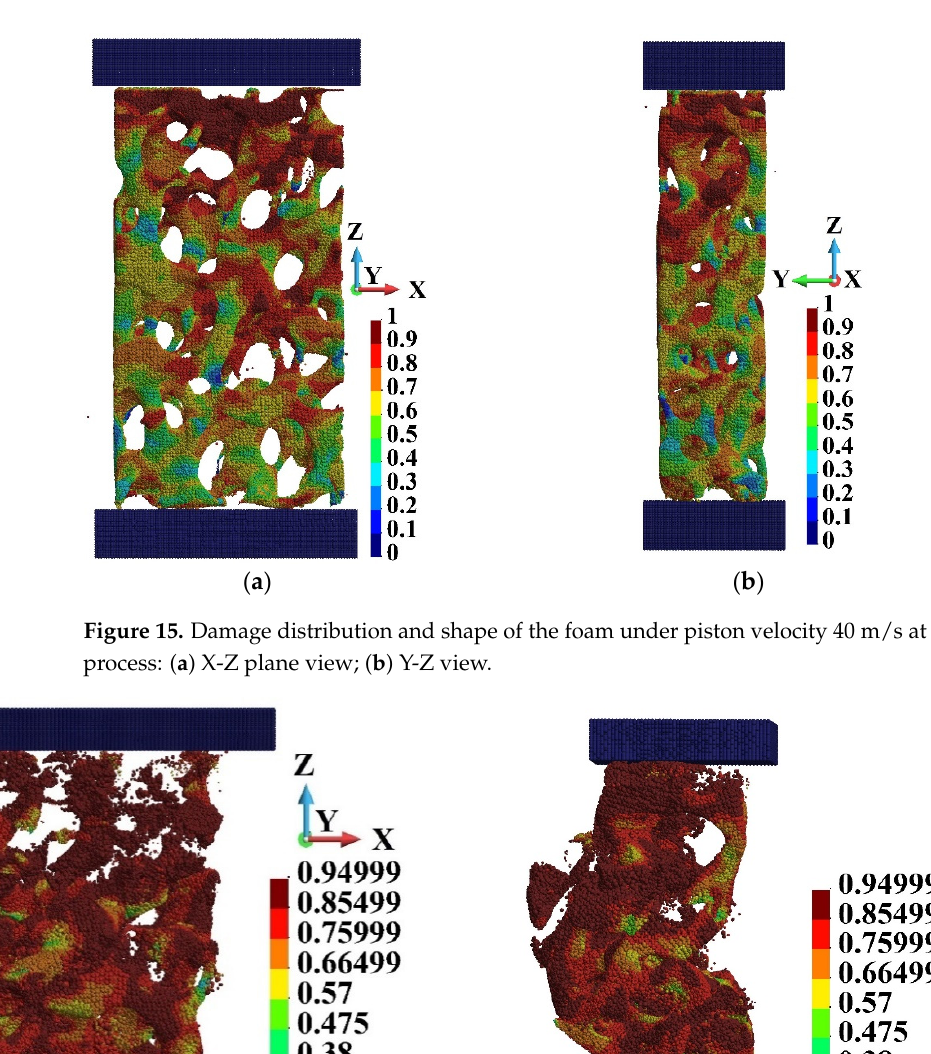
( c ) Figure 14. Damage advancement for the piston velocity 440 m/s at time instants: ( a ) 0.6 × 10 − 06 s; ( b ) 0.3 × 10 − 05 s; ( c ) 0.42 × 10 − 05 s. A significant difference exists between the state of the sample when subjected to the